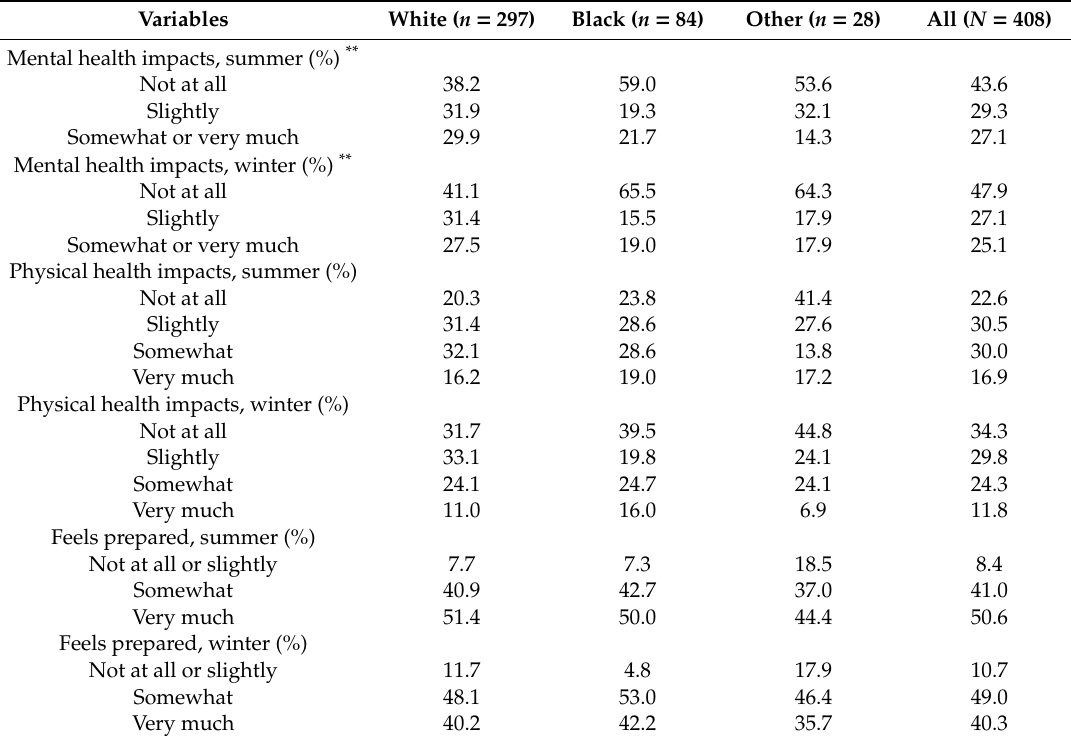
Table 2. Endogenous variables by racial group, weighted (N = 408).